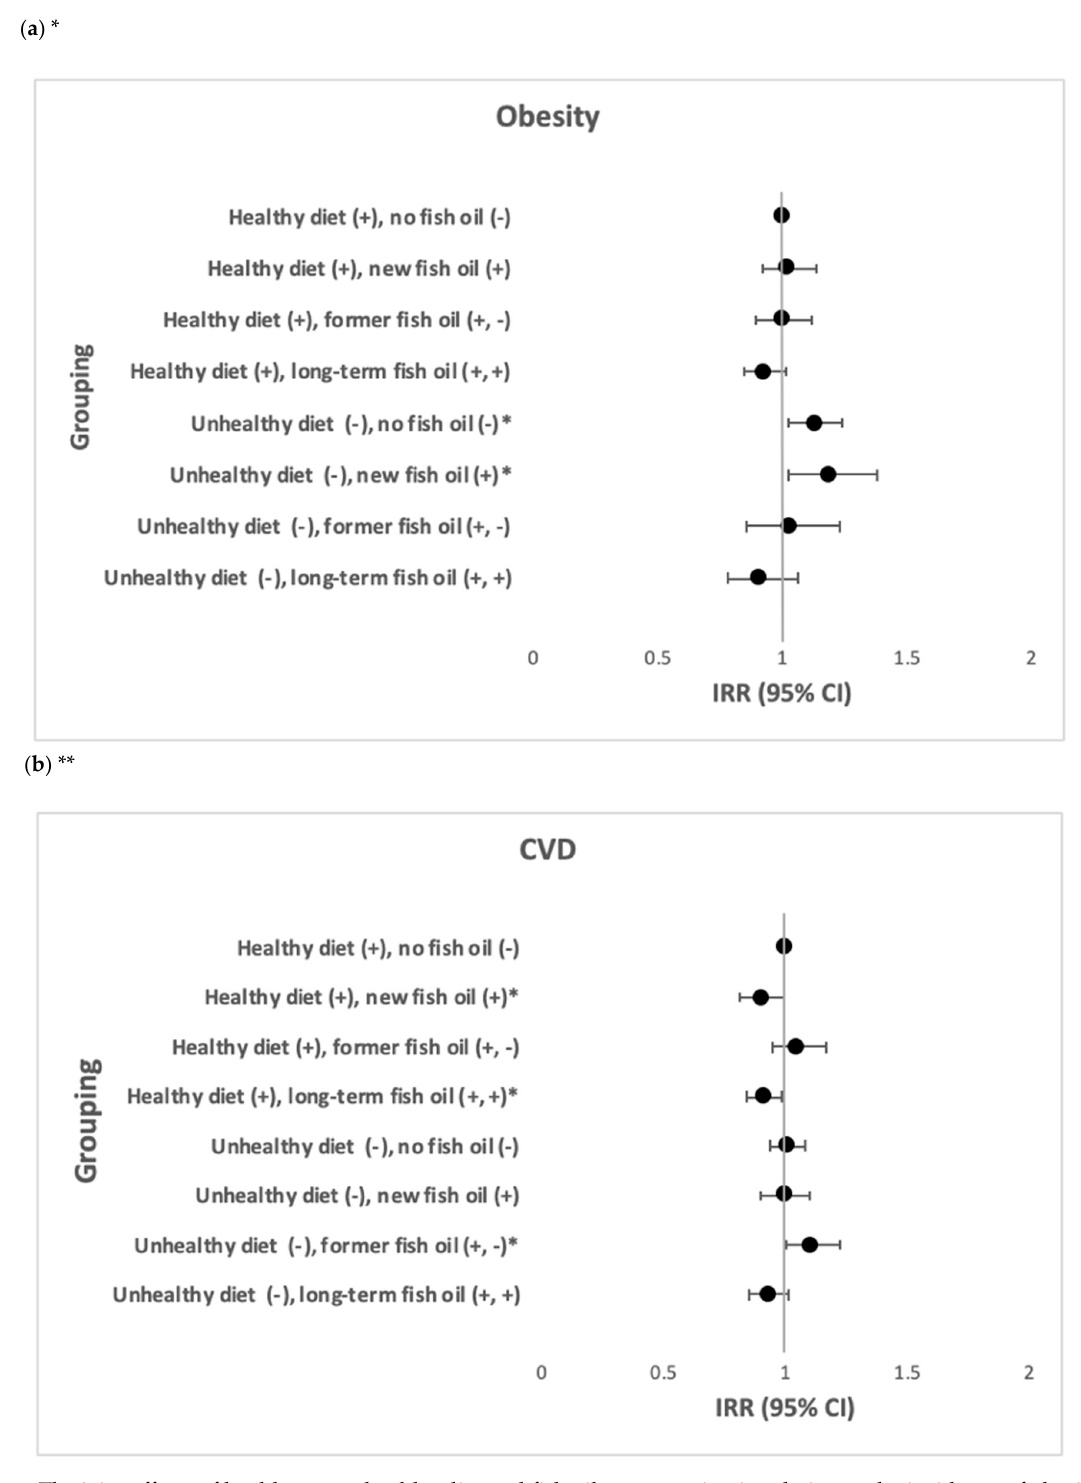
Among participants with a healthy diet, those with new calcium consumption (IRR = 0.84, 95% CI: 0.73; 0.97) and those with former calcium consumption (IRR = 0.64, 95% CI: 0.54; 0.74) had a lower risk of obesity. Participants with a long-term calcium consumption had a lower risk of obesity (IRR = 0.63, 95% CI: 0.54; 0.74) and CVD (IRR = 0.87, 95% CI: 0.78; 0.96). Among participants with an unhealthy diet, those with no calcium consump- tion had a higher risk of obesity (IRR = 1.09, 95% CI: 1.01; 1.17); however, those with former calcium consumption (IRR = 0.69, 95% CI: 0.47; 0.97) and those with a long-term calcium consumption (IRR = 0.71, 95% CI: 0.52; 0.98) had a lower risk of obesity (Figure 5). No associations were observed between joint effect of diet and calcium and the incidence of comorbid obesity and CVD (Table 3).